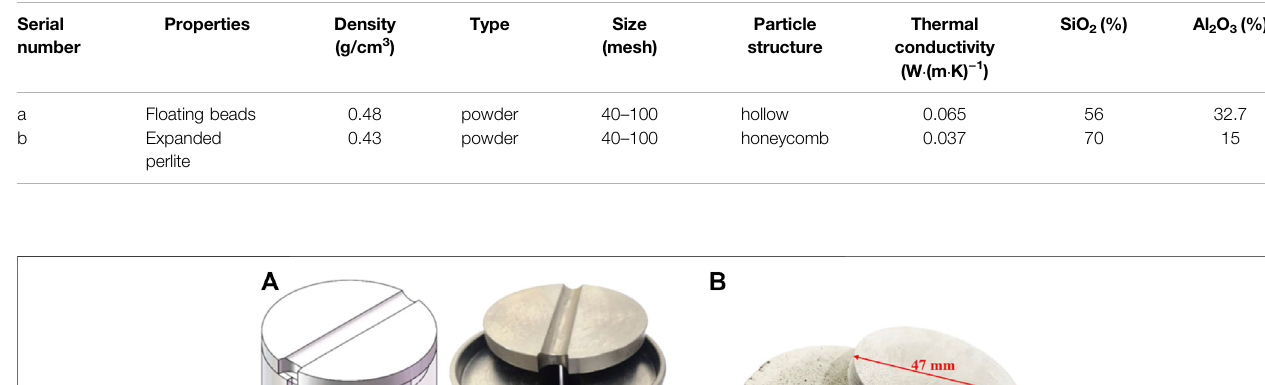
TABLE 3 | Properties of thermal insulation materials.